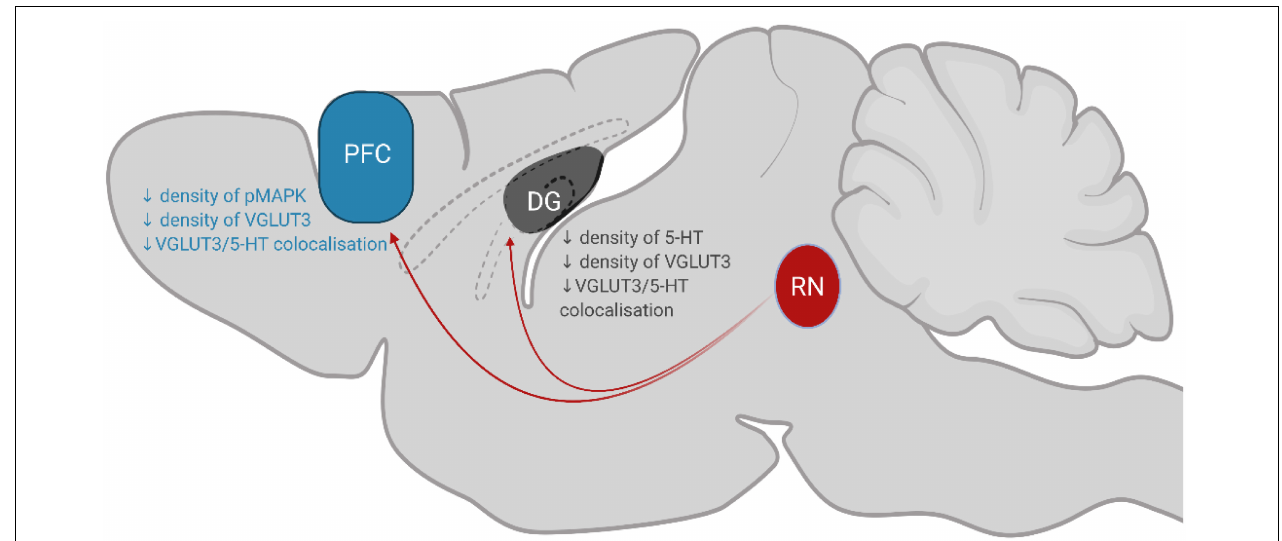
FIGURE 5 | Summary of key findings. Serotonergic neurons in the RN (coloured red; dorsal, median and caudal raphe nuclei) project to the PFC and DG to modulate behaviours associated with eating. Chronic, low-concentration sucrose consumption causes a decrease in the density of pMAPK, VGLUT3 and 5-HT/VGLUT3 co-localisation in the PFC (coloured blue). In the DG of the hippocampus (coloured grey), sucrose consumption decreases the density of 5-HT, VGLUT3 and 5-HT/VGLUT3 co-localisation. RN, raphe nuclei; DG, dentate gyrus; PFC, prefrontal